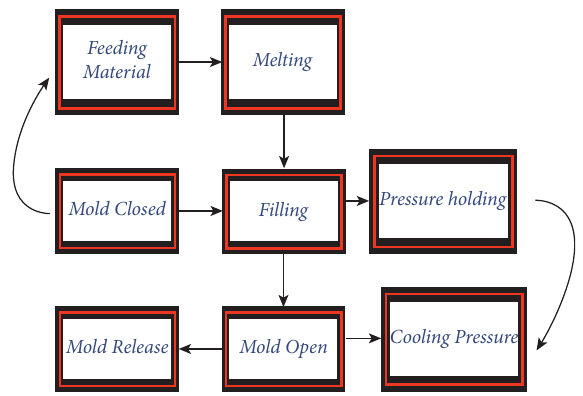
Figure 1: Injection molding process includes feeding and